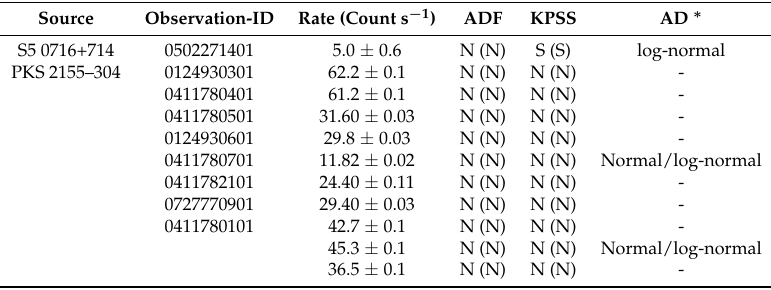
Table 2. Results of Stationarity test using ADF and